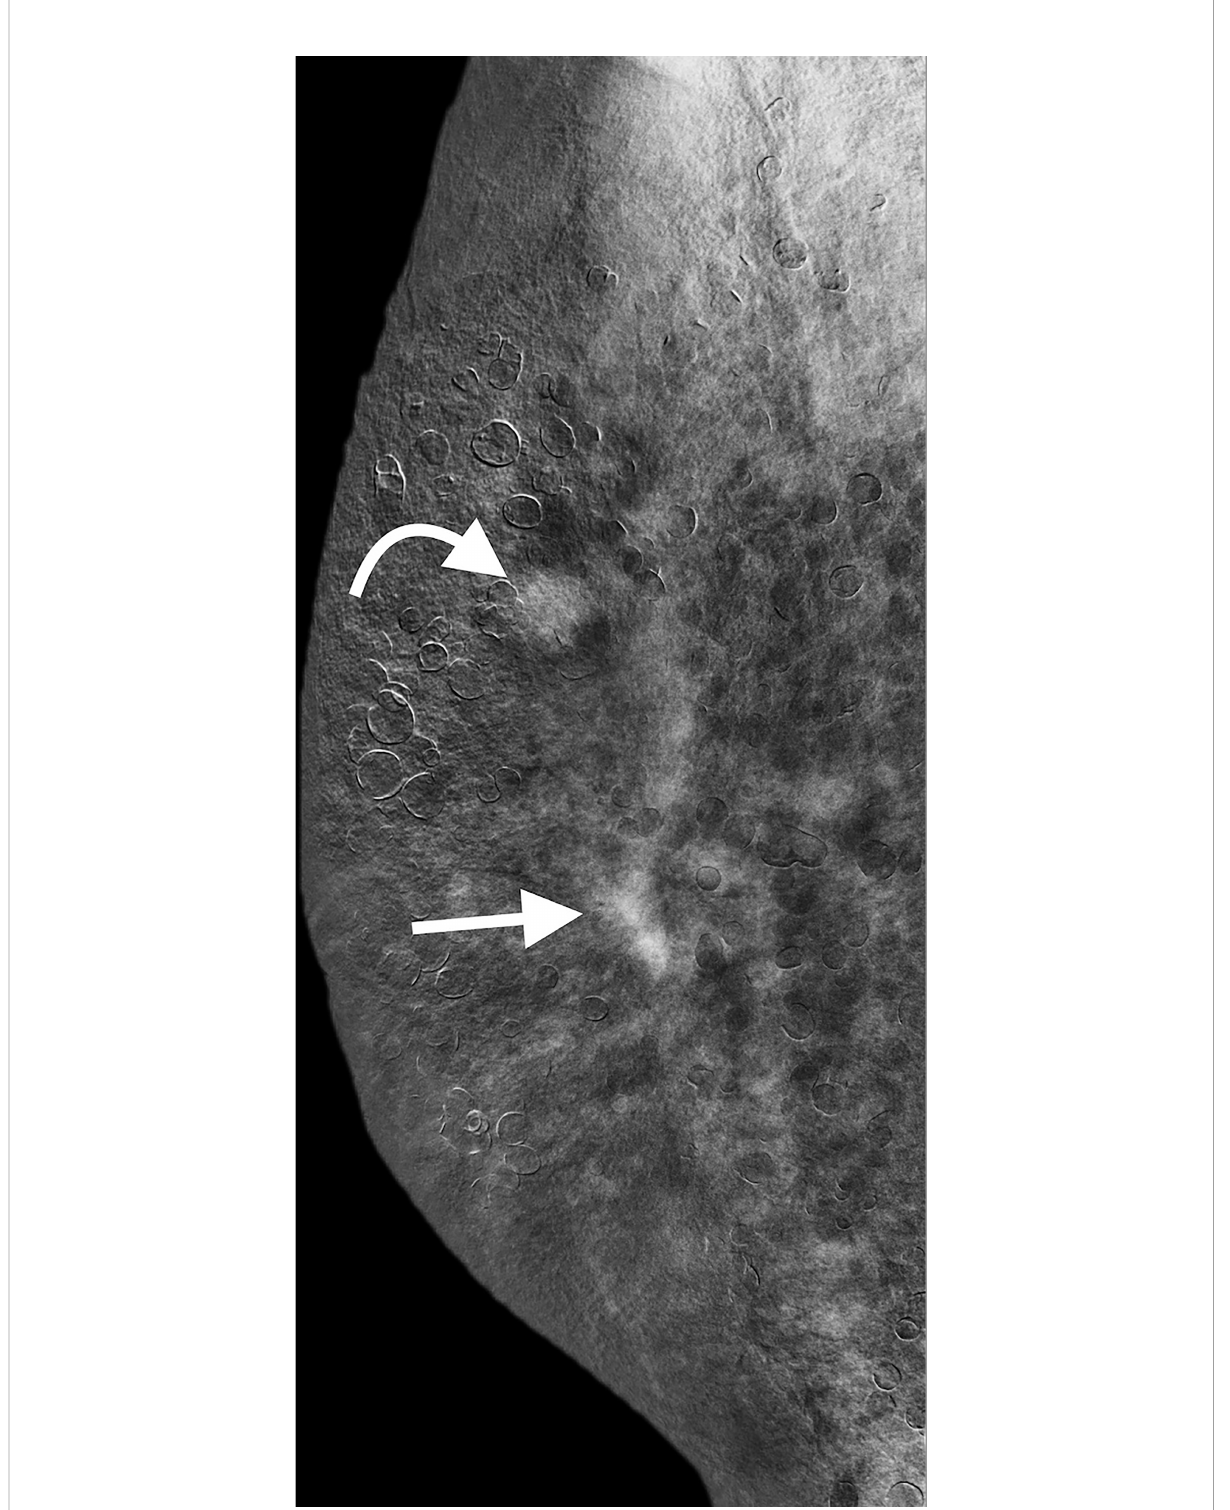
FIGURE 3 CESM (REI in lateral view) revealed the irregular enhanced mass (straight arrow) and circumscribe enhanced mass (curved arrow) in the right breast, which were compatible with CE-MRI fi ndings. CESM, contrast-enhanced spectral mammography; REI, recombine enhanced image; CE-MRI, contrast-enhanced magnetic resonance